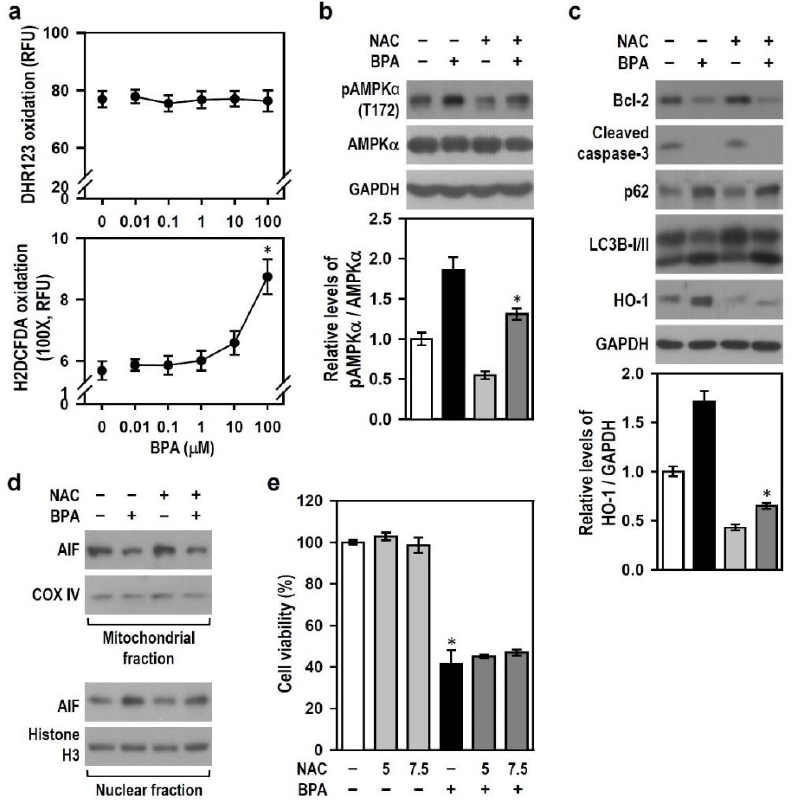
Figure 9. N-acetyl-L-cysteine (NAC) reduces BPA-induced AMPKα phosphorylation and HO-1 production but exerts no effect on stress signalings related to cell degradation. ( a ) Cultures were